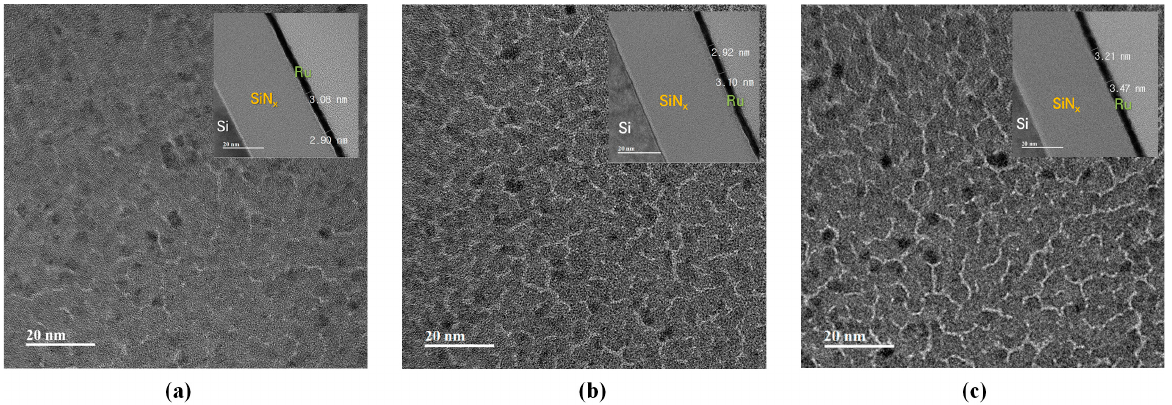
Figure 2. TEM analysis results of the Ru thin film deposited by sputtering with a working pressure of ( a ) 0.5, ( b ) 1.0, ( c ) 2.0